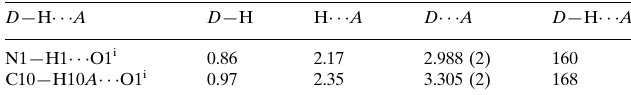
Hydrogen-bond geometry (A˚ , (cid:2)